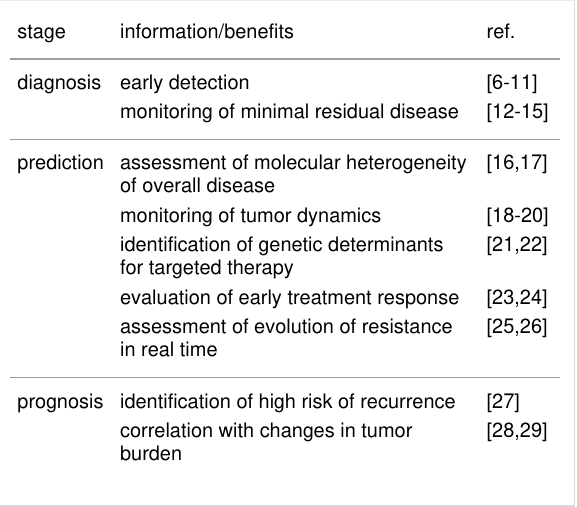
Table 1: Benefits of liquid biopsy in diagnosis, prediction and prog- nosis of cancer.